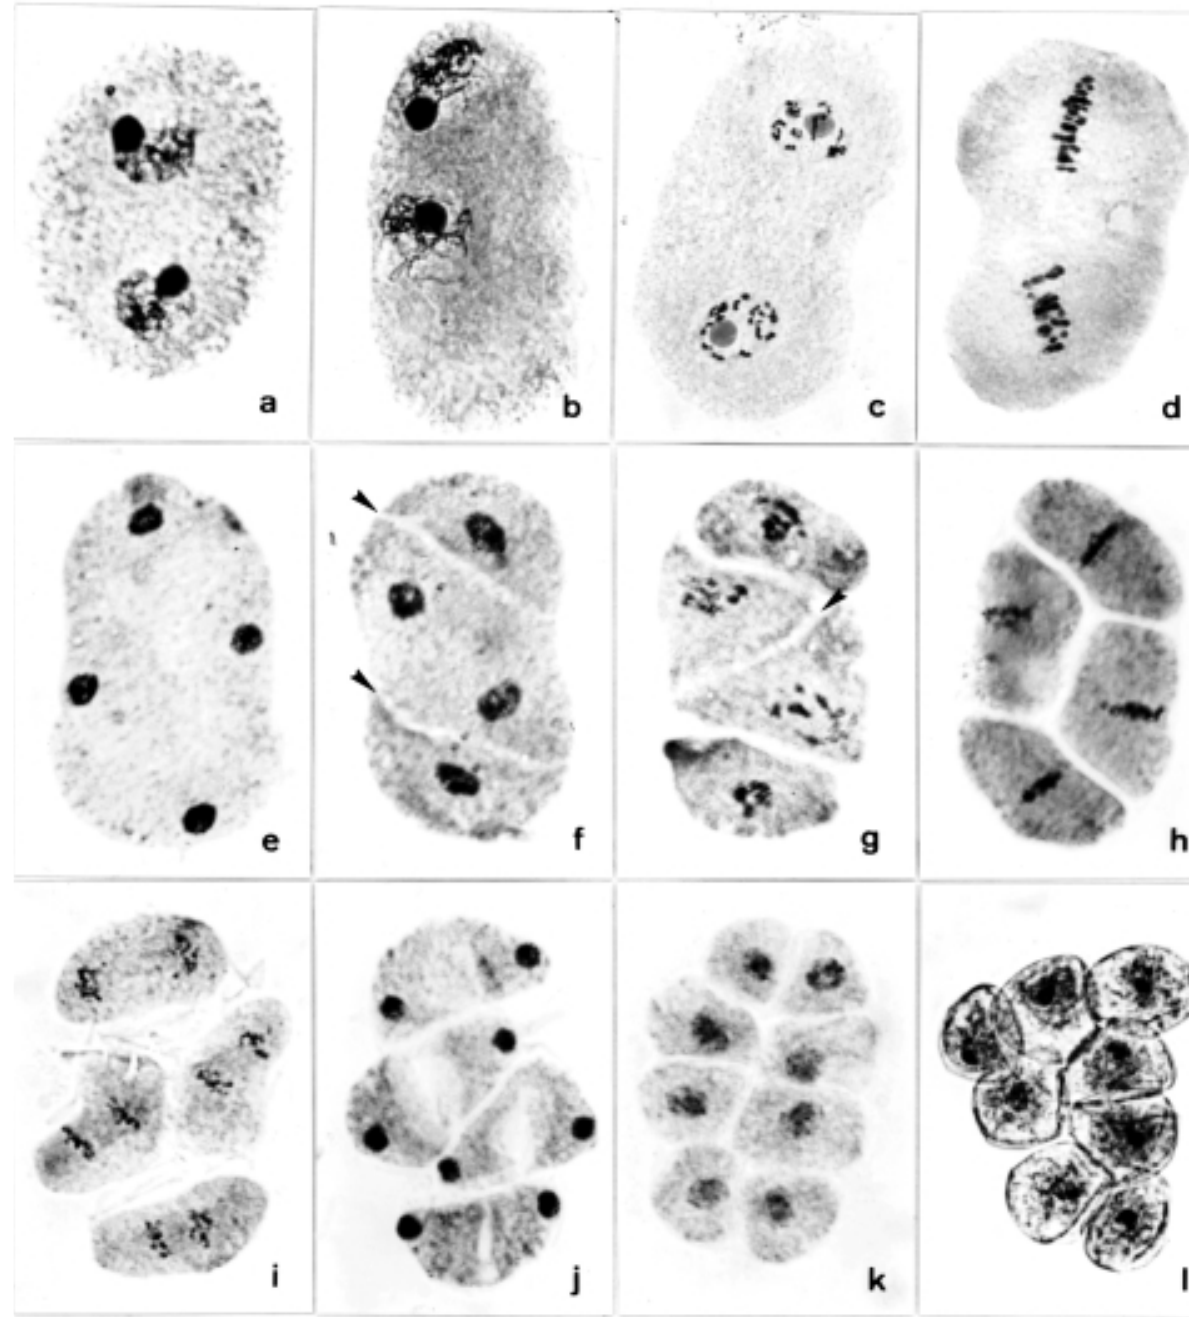
Figure1 -Microsporogenesisinsyncytesof B.jubata. a)Zygotene.b)Pachytene.c)Diakinesis.d)MetaphaseI.e)TelophaseI.f)Normalcytokinesisaf- ter telophase I (arrowhead). g) Additional cytokinesis before prophase II (arrowhead). h) Metaphase II. i) Anaphase II. j) Telophase II with normal cytokinesis. k) Octad. l) Pollen